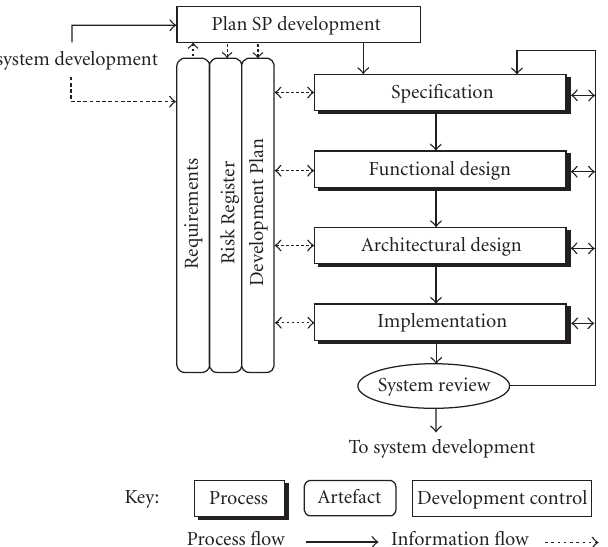
Figure 1: Iterative development